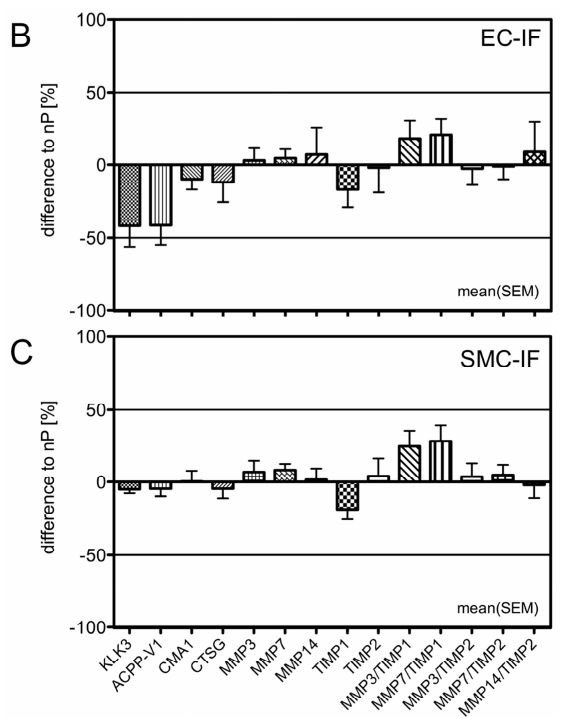
Figure 6. CLSM analysis in seminal vesicles (SV). ( A – C ) Immunofluorescence in SV ( n = 6) was normalized to the IF in nP ( n = 6). Parameter-free Mann–Whitney test detected no significant differences between expression levels in nP and SV, but considerably lower IF was found for KLK3 and ACPP-V1, especially in epithelial cells (EC, B ).